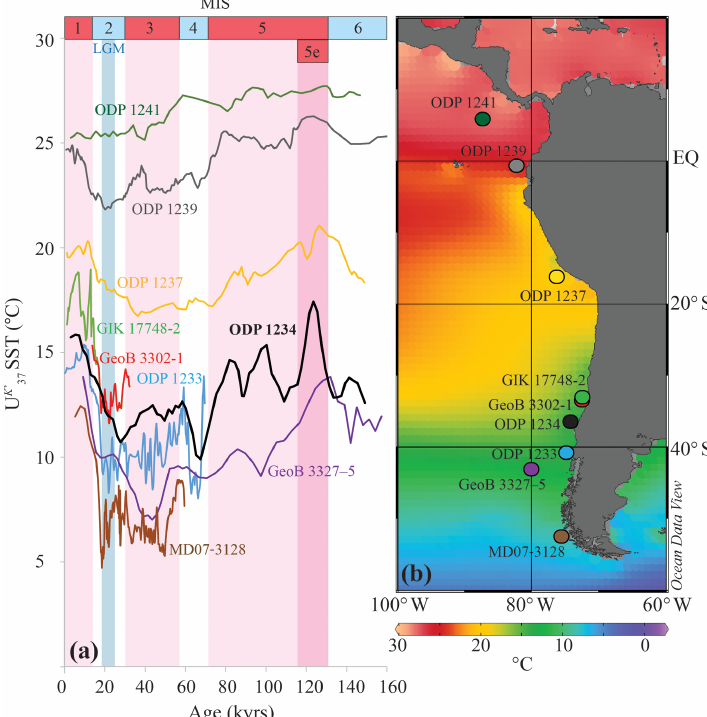
(cid:48) SST reconstructions off South America for the last ∼ 160kyr (3-point running averages). (b) Sea surface temper- Figure 7. (a) Pacific U K 37 ature ( ◦ C) map for the region. The colors of the records correspond to the colors of the site symbols in the map. Alkenone-based SST data is from Caniupán et al. (2011) (MD07-3128; 53 ◦ S), Ho et al. (2012) (GeoB 3327-5; 43 ◦ S), Kaiser et al. (2005) (ODP1233; 41 ◦ S), this study (ODP 1234; 36 ◦ S), Kim et al. (2002) (GeoB 3302-1 and GIK 17748-2; 33 ◦ S), Bin Shaari (2013) (ODP 1237; 16 ◦ S), Bin Shaari et al. (2013) (ODP 1239; 1 ◦ S) and Bin Shaari et al. (2014) (ODP 1241; 6 ◦ N). Surface temperature data derived from the World Ocean Atlas 2013 (Locarnini et al., 2013); map is drawn in Ocean Data View (Schlitzer, 2015), and modified manually.